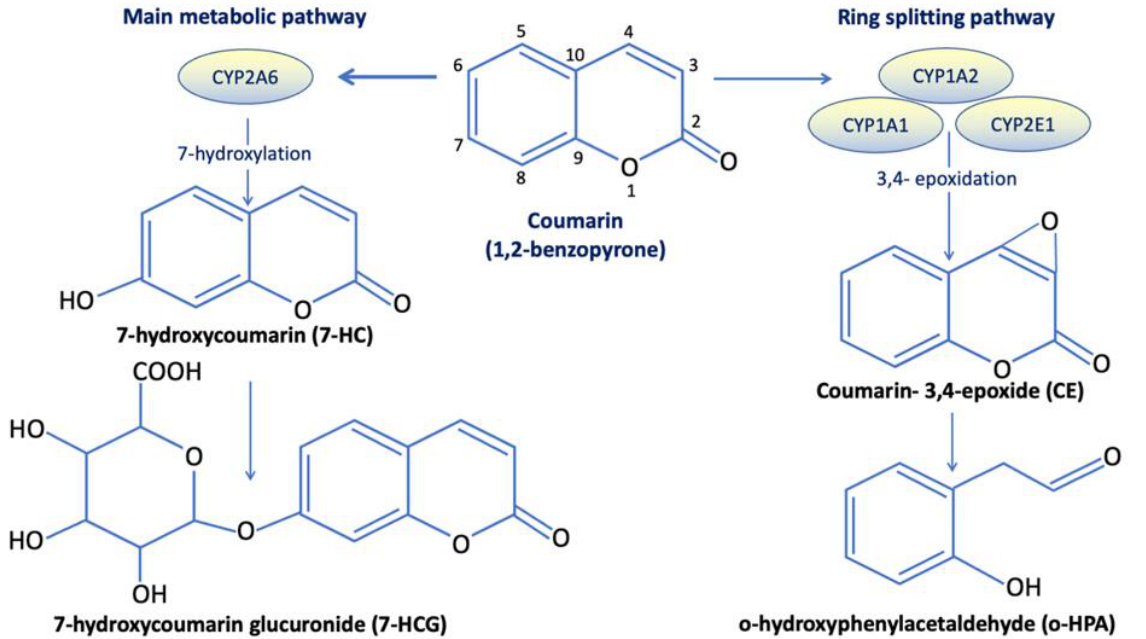
Figure 3. Coumarin metabolic pathways and its main metabolites in humans. Coumarin can be metabolized either through the main metabolic pathway mediated by cytochrome P450-linked mono-oxigenase enzyme system (CYP2A6) ( left ) or through the uncommon ring-splitting pathway, mediated by other cytochrome P450 isoforms (namely CYP1A1, CYP1A2, and CYP2E1), which leads to the production of the hepatotoxic metabolite o-HPA ( right ).